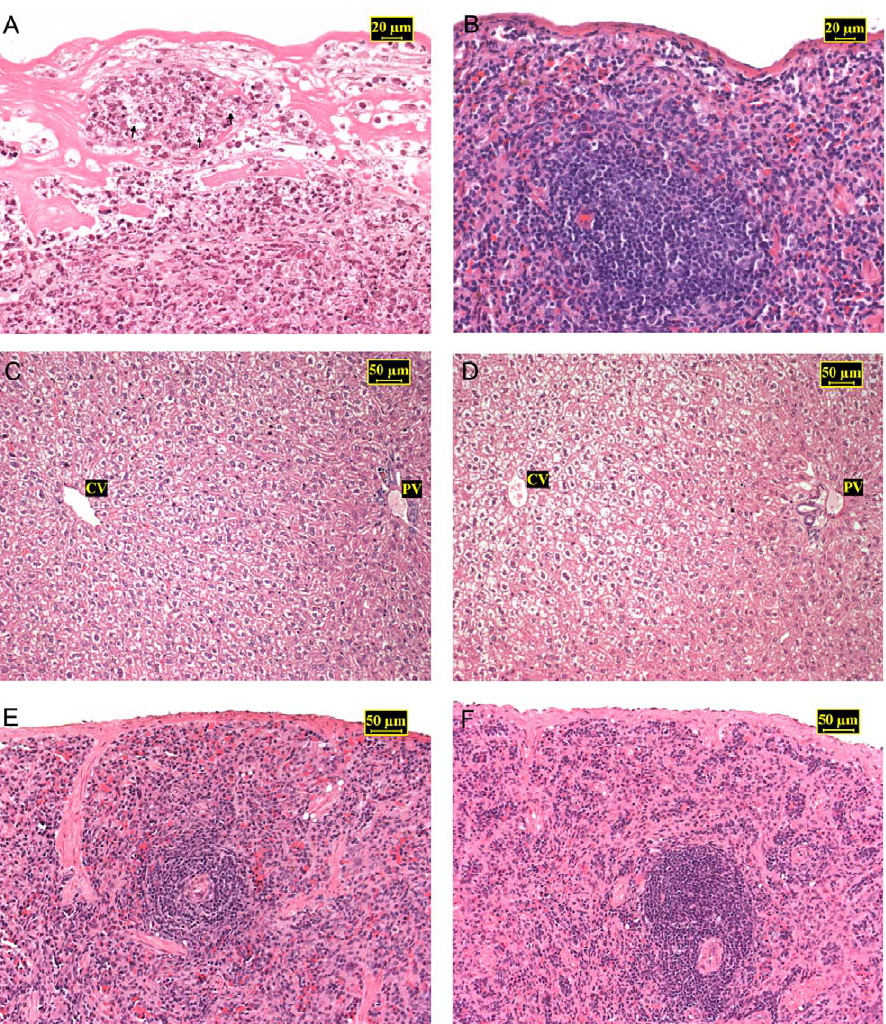
Figure 5. Photomicrographs of spleen and liver sections from Leishmaniabraziliensis or L.infantum infected rodents stained with haematoxylin-eosin. A: L. braziliensis -infected golden hamster ( Mesocricetus auratus ) 3 months post infection (mpi) – spleen revealed extensive necrosis and inflammation. Note necrotic focus containing amastigotes (arrows). B: L. braziliensis -infected Thrichomys laurentius (7289) 3 mpi – spleen showing architecture of red and white pulp, lack of parasites; C: L. infantum -infected T. laurentius (7548) 12 mpi (liver culture tissue positive) – panoramic view of the liver showing typical architecture with portal (PV) and central vein (CV); D: L. infantum - infected T. laurentius (7538), 12 mpi (liver culture tissue negative) – also illustrated liver showing normal architecture; E: L. infantum -infected T. laurentius (7548), 12 mpi (liver culture tissue positive) – overview of white and red pulp from spleen; F: L. infantum -infected T. laurentius (7538), 12 mpi (liver culture tissue negative) – also illustrated spleen overview of red and white